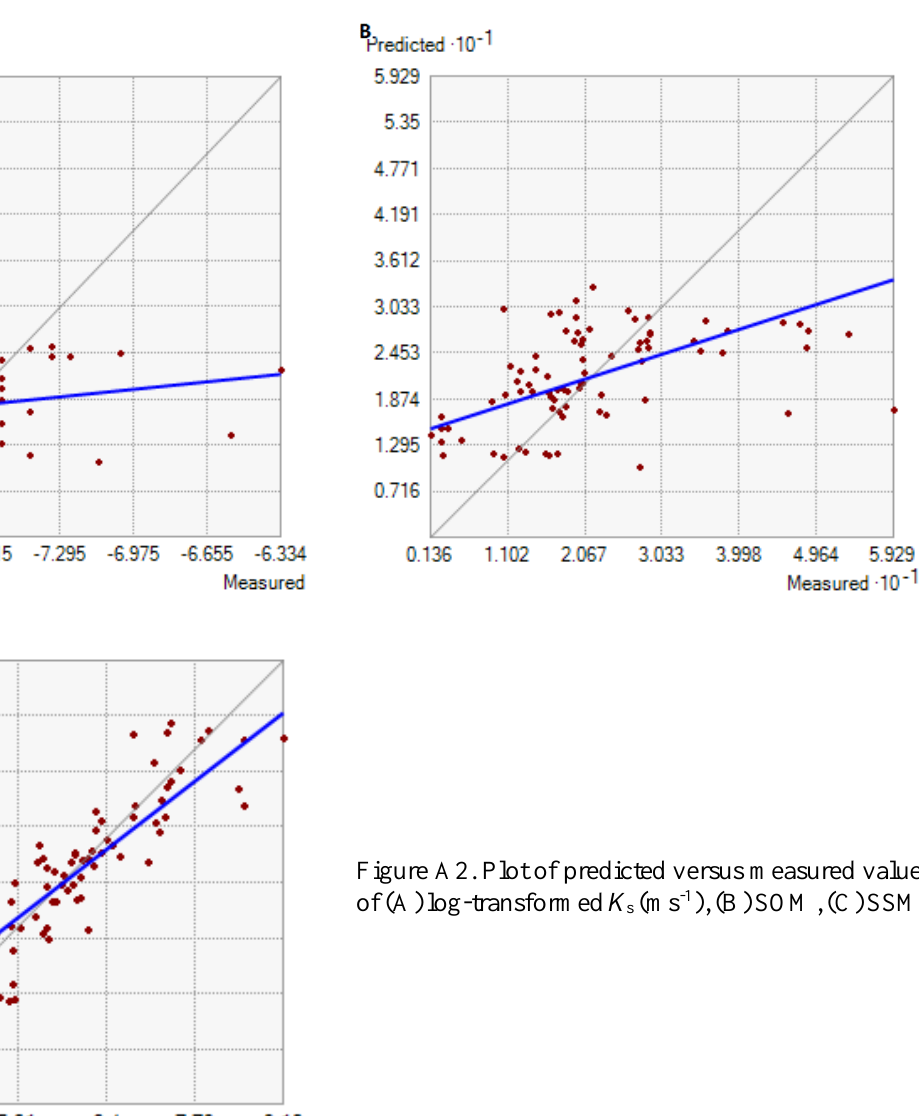
Figure A1: Comparison of K s log-transformed values between field measurements using direct-push piezometer and laboratory measurements using constant-head upward-flow permeameter.